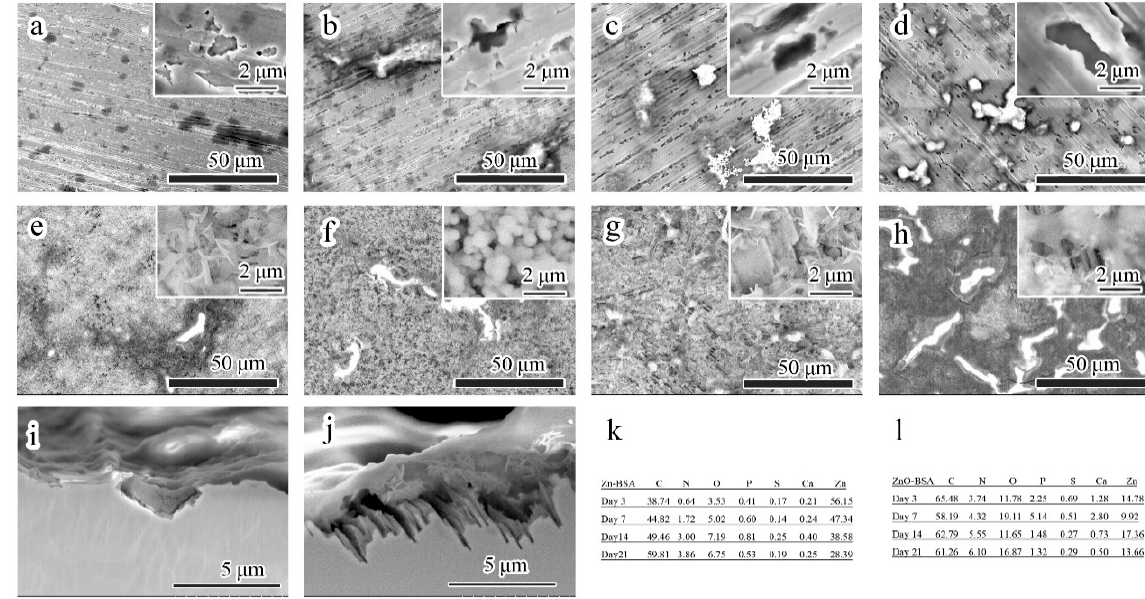
Figure 7. SEM micrographs of samples after immersion in SBF/BSA: ( a – d ) Zn for 3 days, 7 days, 14 days, and 21 days; ( e – h ) Zn/ZnO for 3 days, 7 days, 14 days, and 21 days. ( i , j ) Cross-section of Zn and Zn/ZnO after 21 days immersion; ( k , l ) EDS data for Zn and Zn/ZnO after 21 days immersion.